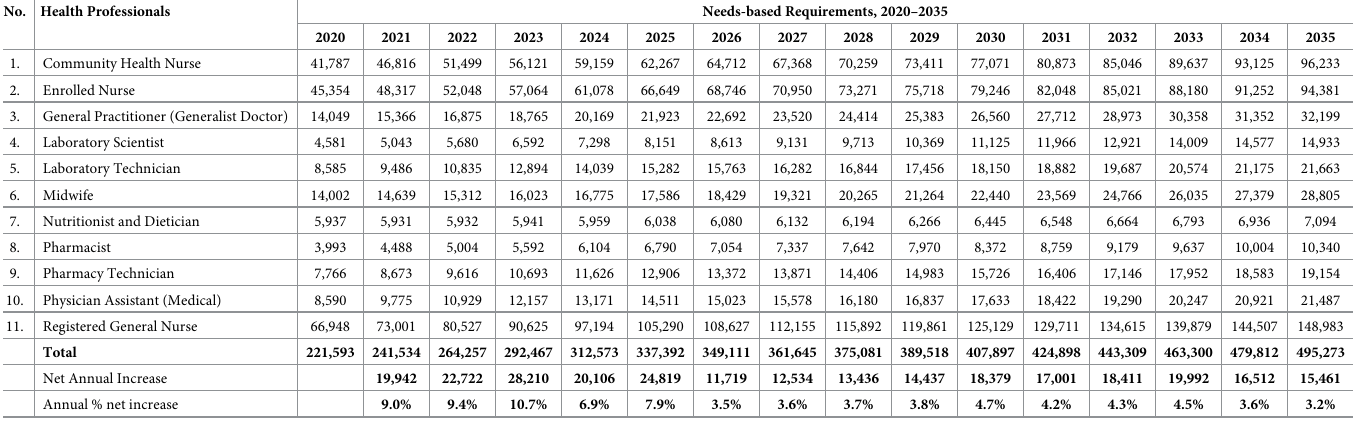
Table 3. Projected needs-based requirements of health professionals,